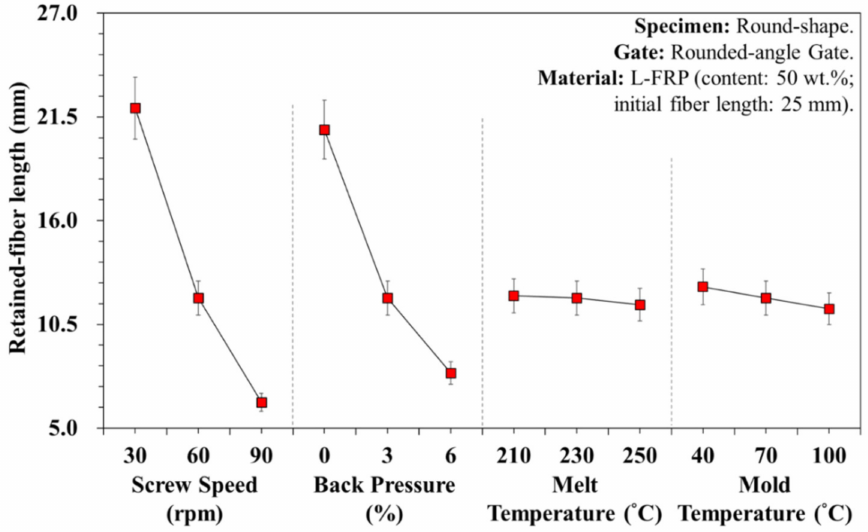
Figure 7. Variations of fiber breaking length under different plasticization parameters.